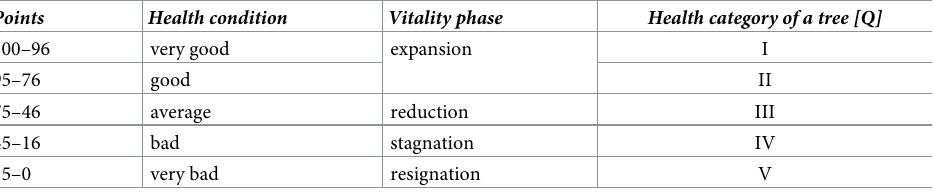
Table 3. Phases of vitality, health condition and health category of the examined